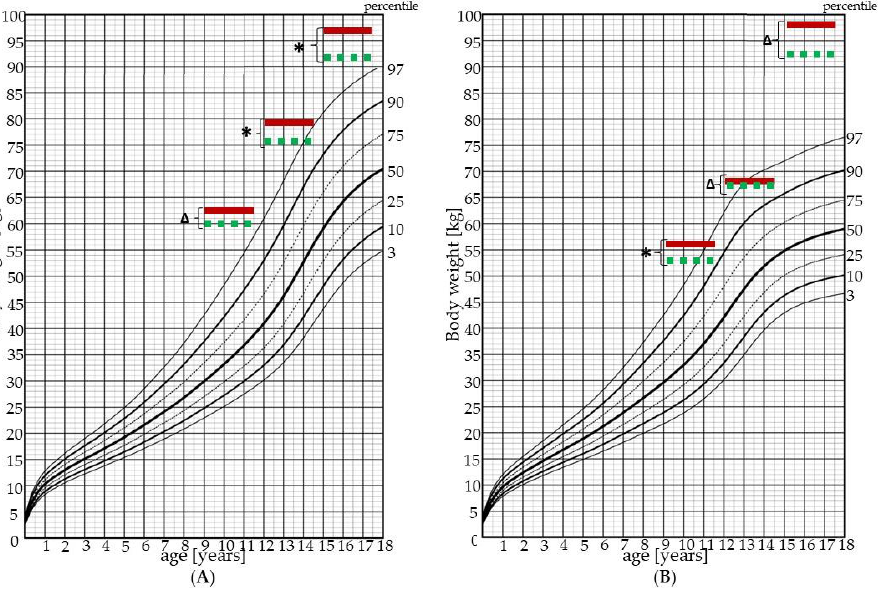
Figure 2. Body weight (BWT) in measurements I. and II. for males ( A ) and females ( B ). Solid red line represents measurement I., which was made at the beginning of the one-month stay in the children’s hospital, dashed green line represents measurement II., made at the end of the one-month stay in the children’s hospital. *— p value is less than 0.01; Δ— p value is less than 0.05; p value— statistical evaluation of the differences between the measurements I. and II., Wilcoxon signed-rank test (paired test).